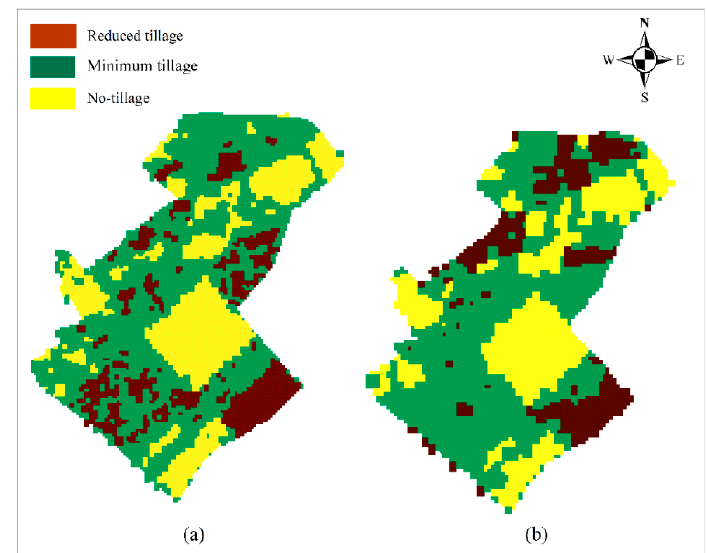
Figure 9. SSR map using the nearest neighbour (NN) classification method in OBIA: ( a ) Sentinel-2A image, ( b ) Landsat-8 image.